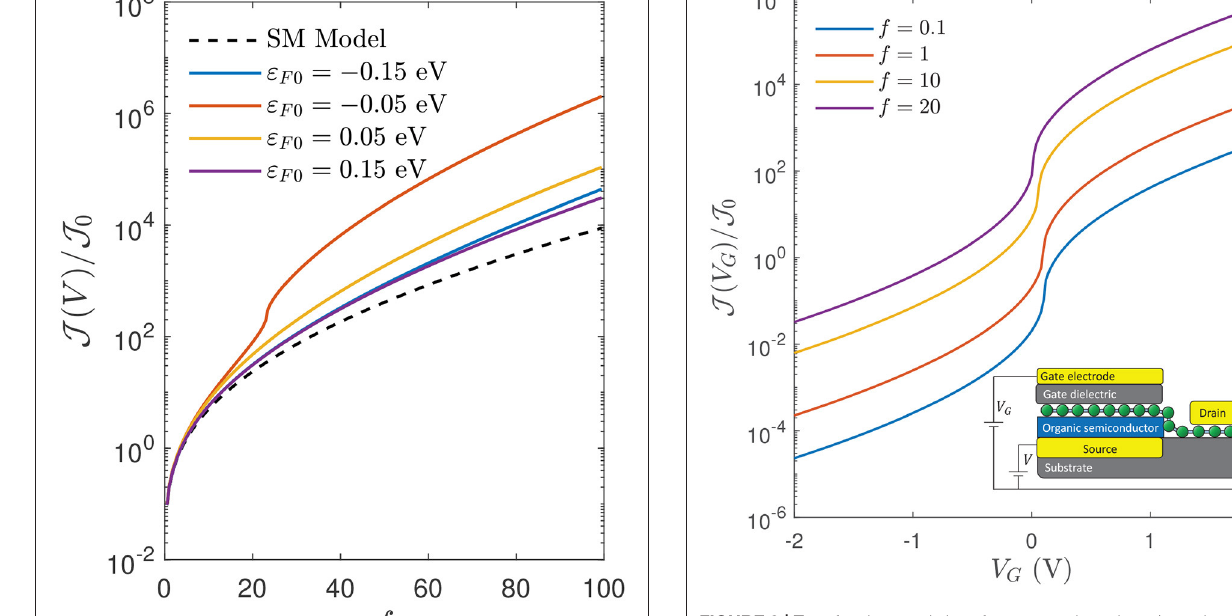
3.5 and room temperature =